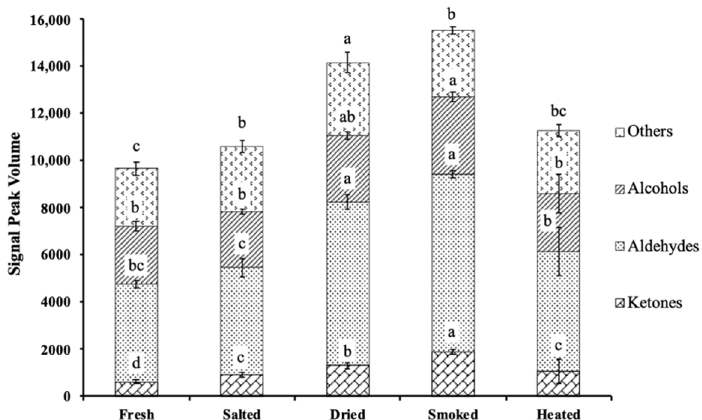
Figure 7. The signal peak volume distribution diagram of volatile compounds of smoke-flavored sea bass with different production steps via HS-GC-IMS. Values with different letters differ significantly ( p < 0.05).